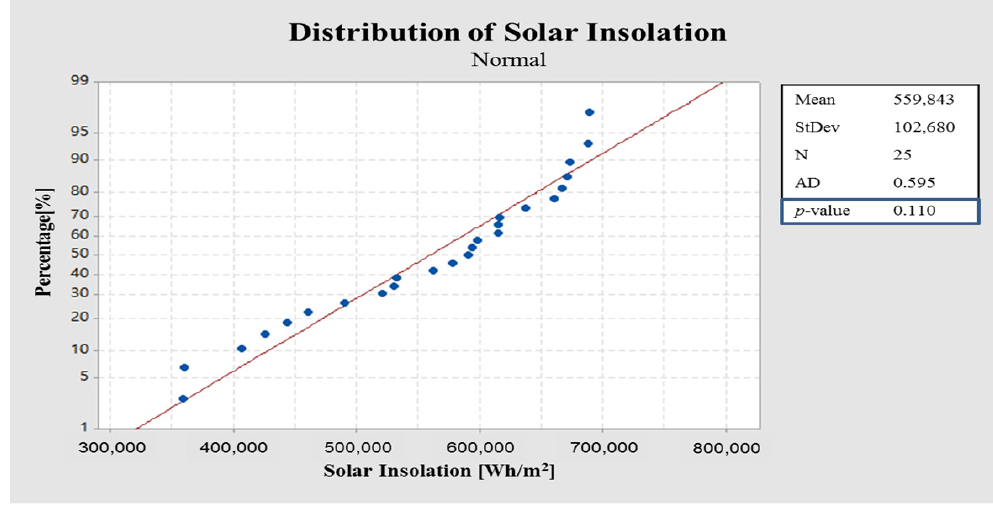
Figure 5. Normality test of solar insolation for different installation angles.